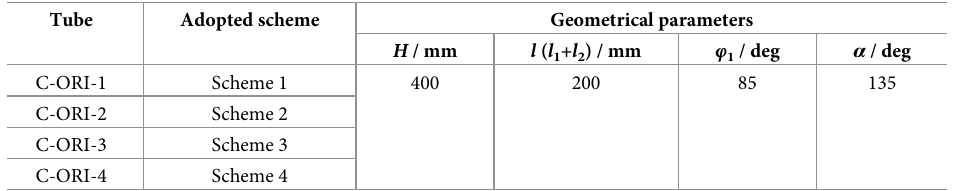
Table 1. Modelling information of patterned